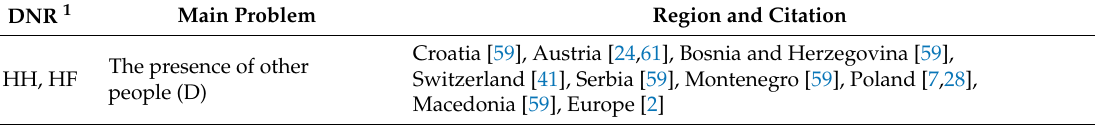
Table 4. Discomforts (D) and threats (T) in relations between users of urban and suburban forests. DNR 1 Main Problem Region and